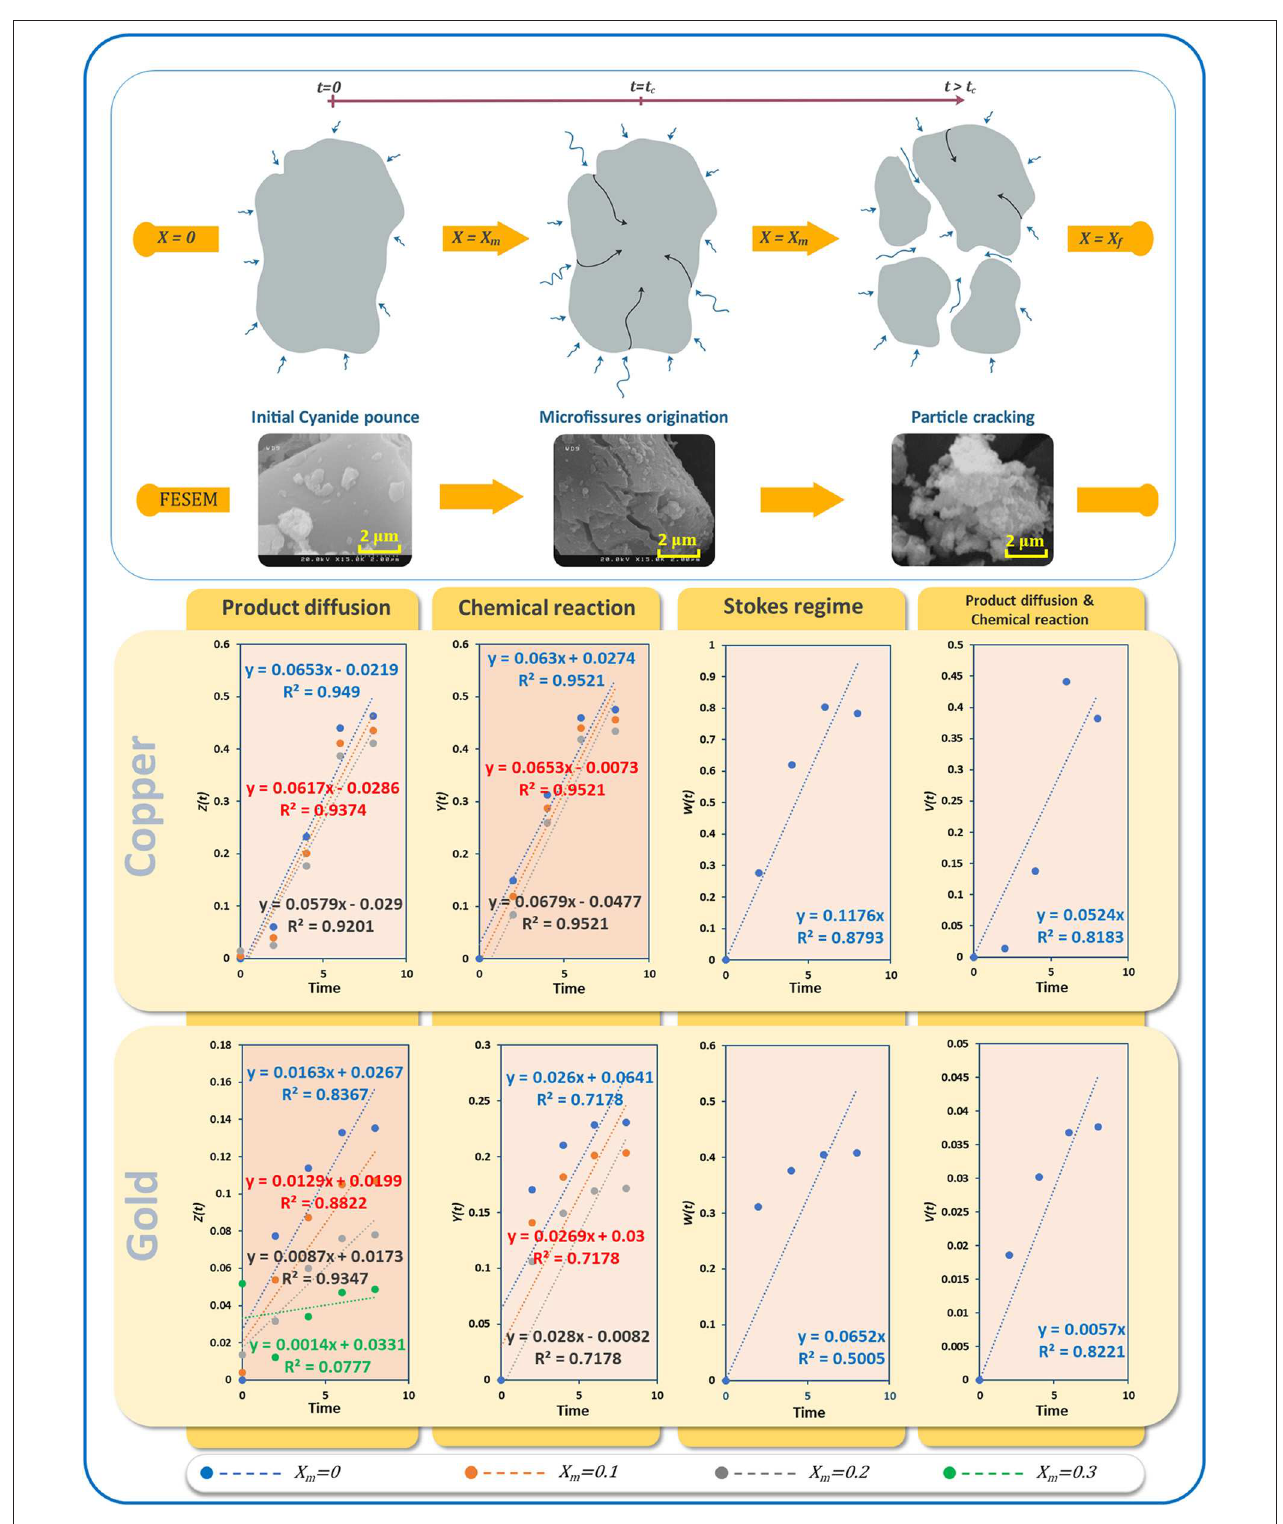
FIGURE 12 | (A) Schematic of the crackling core method of e-waste powder bioleaching, different stages visualized by SEM, (B) linear regression results for different kinetic models of bioleaching of gold and copper.